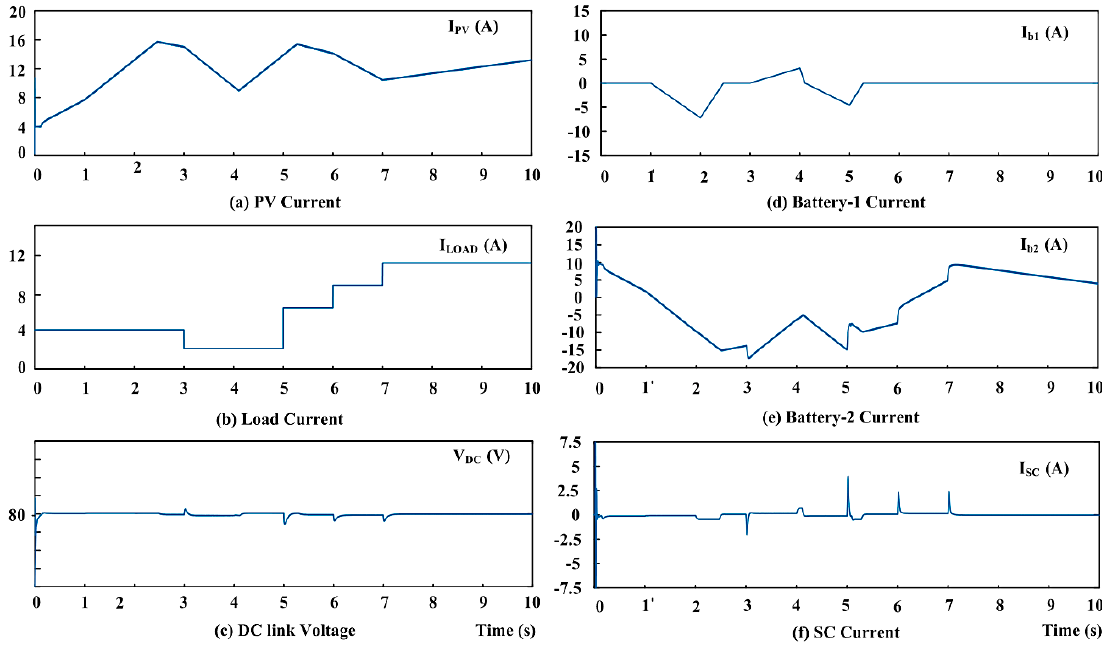
Figure 11. Simulation results.